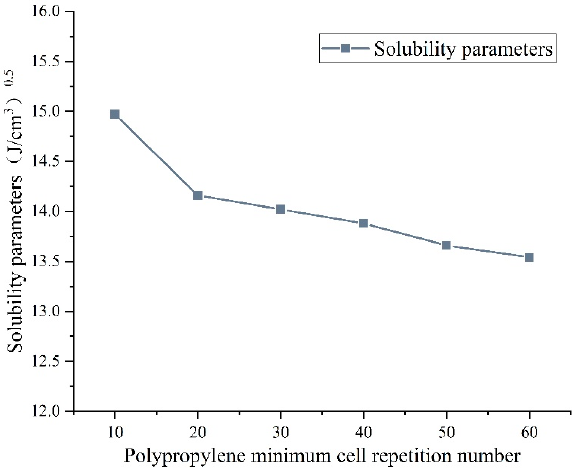
Figure 11. Solubility parameters of polypropylene.